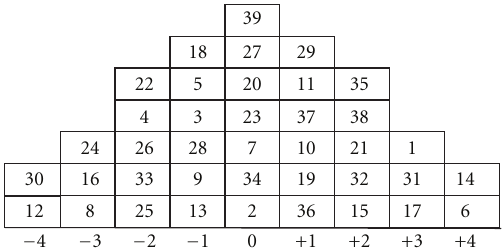
Figure 3: Sample of completed Q-sort grid, showing statement numbers, arranged in rank order from − 4 (most unlike my own experience) to +4 (most like my own